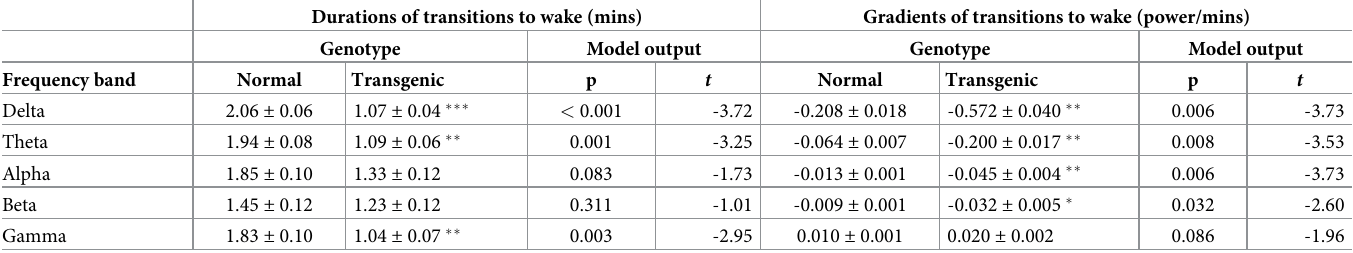
Table 2. Differences in durations and gradients of transitions to wake for each frequency band between normal and HD transgenic sheep. Durations of transitions to wake